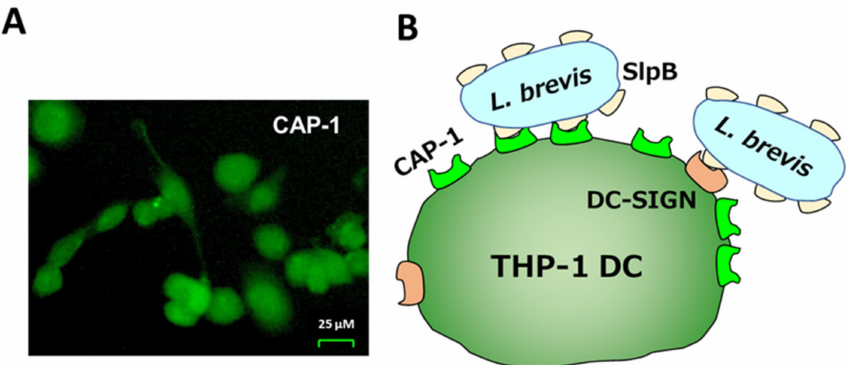
Figure 6. ( A ) Immunostaining of THP-1 DC with anti-CAP-1 antibody. CAP-1 on THP-1 DC was detected by incubation with FITC-labelled anti-CAP-1 antibody. ( B ) Illustration for L. brevis JCM 1059 binding of SlpB with CAP-1 and